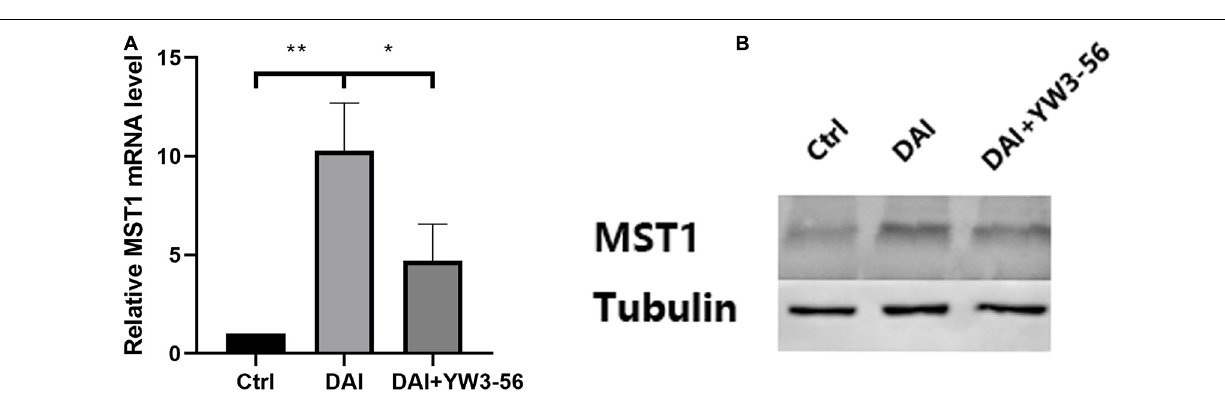
FIGURE 6 | (A) The levels of Mammalian STE20-like protein kinases 1 (MST1) mRNA in the control group, DAI group and DAI + YW3-56 group were detected by qPCR. (B) The levels of MST1 protein expression in the control group, DAI group and DAI + YW3-56 group were detected by WB (* P < 0.05 and ** P <